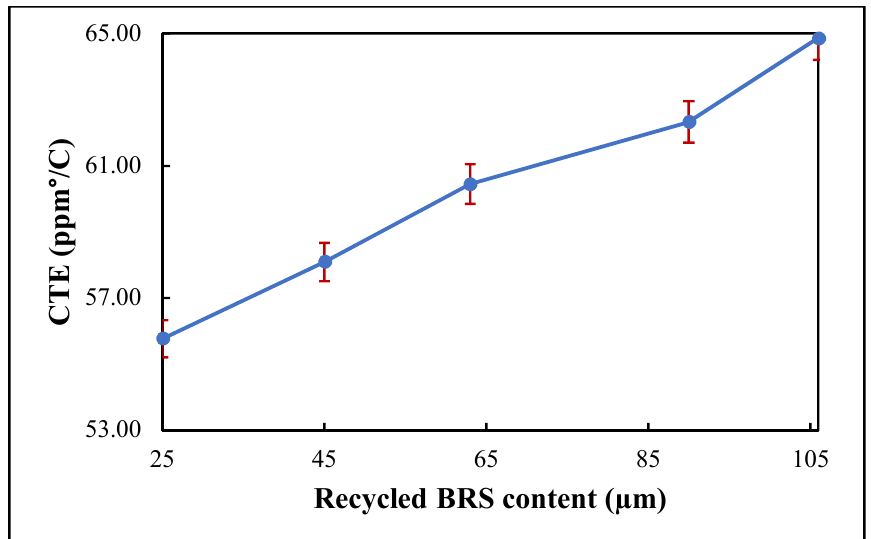
Figure 8. Variation of CTE with filler size.